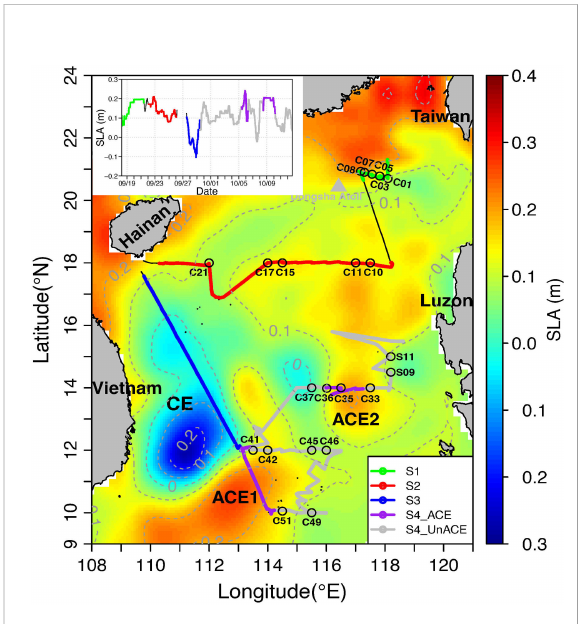
FIGURE 1 Map of sampling stations based on the average sea level anomaly (SLA) from 18/09/2018 to 14/10/2018. The top left box indicates the matched daily sea level anomaly (SLA) of the cruise track. The black dots were stations with phytoplankton pigment survey during the cruise. The color lines were the cruise track, which can be divided into four transects: S1 was selected as the continental shelf of northern SCS; S2 referred to the basin of northern SCS; S3 located in the western SCS where cyclonic eddies occurred; S4 distributed in the basin of southeastern SCS. CE, cyclonic eddy; ACE, anticyclonic eddy. S1, S2, S3, S4_ACE (through ACE1 and ACE2), and S4_UnACE (outside ACE1 and ACE2) were in green, red, blue, purple, and gray,